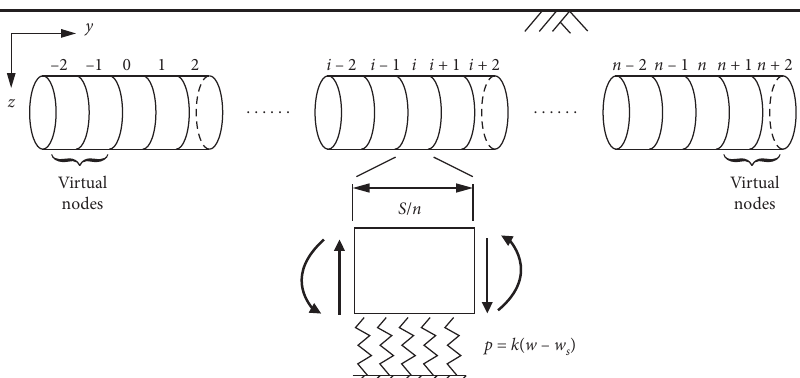
Figure 2: Schematics showing the idealization of tunnel structure as an elastic beam and the simplification of tunnel-soil interaction as beam sitting on elastic